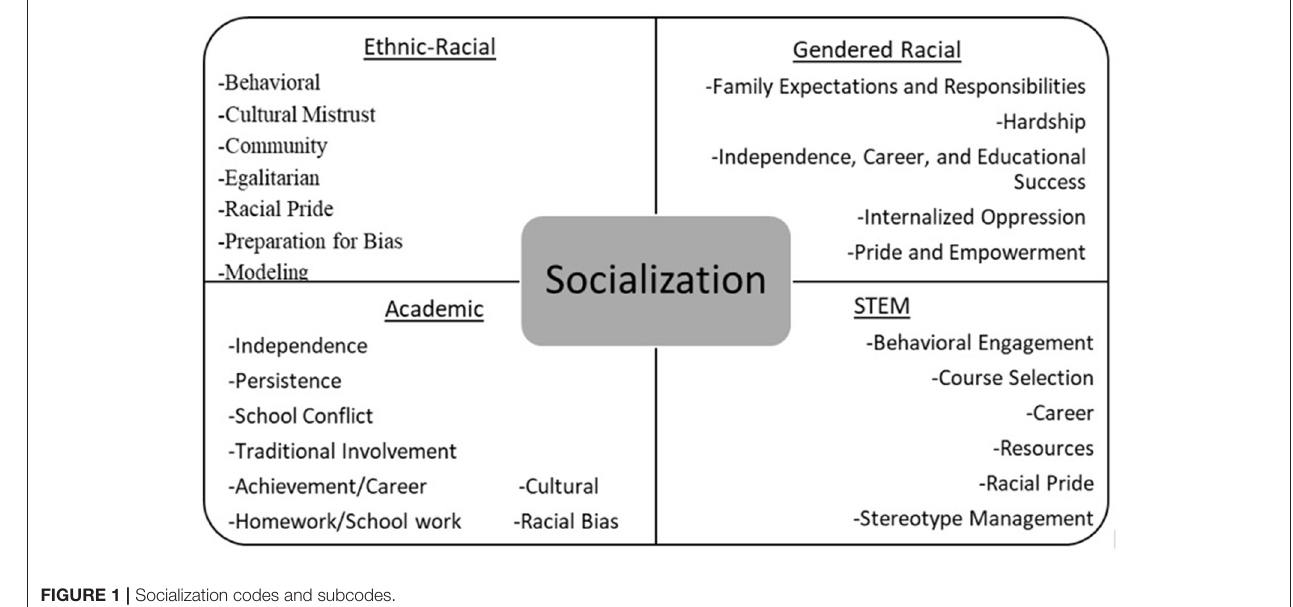
FIGURE 1 | Socialization codes and subcodes.